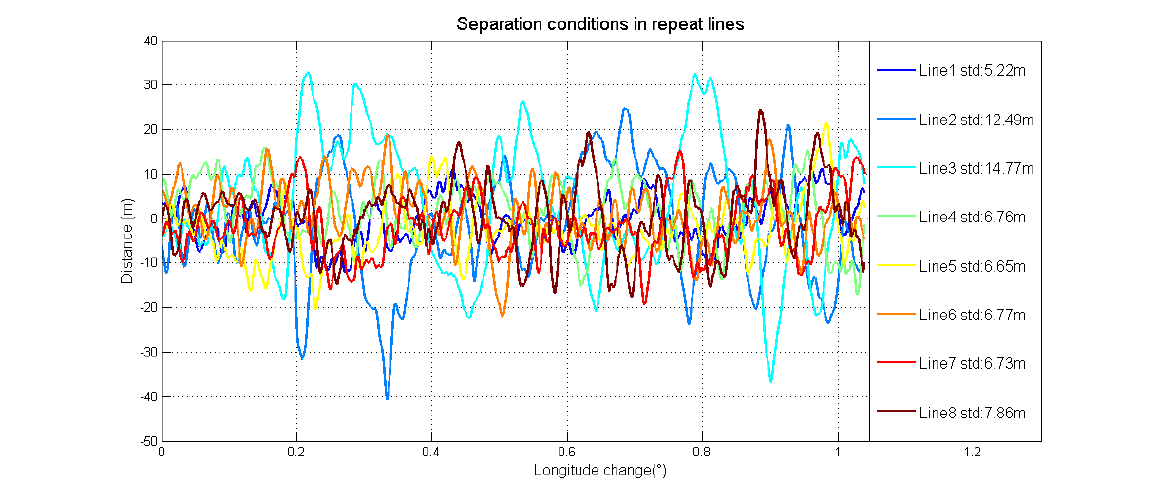
Figure 12. Northward separation conditions in repeat lines.